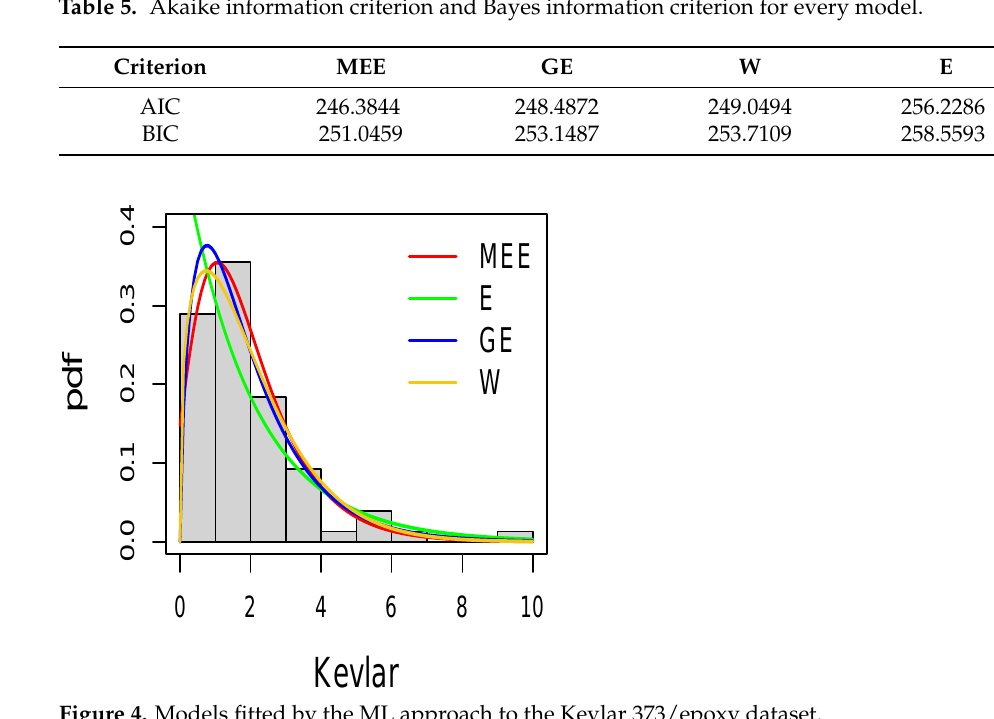
Table 5. Akaike information criterion and Bayes information criterion for every model.